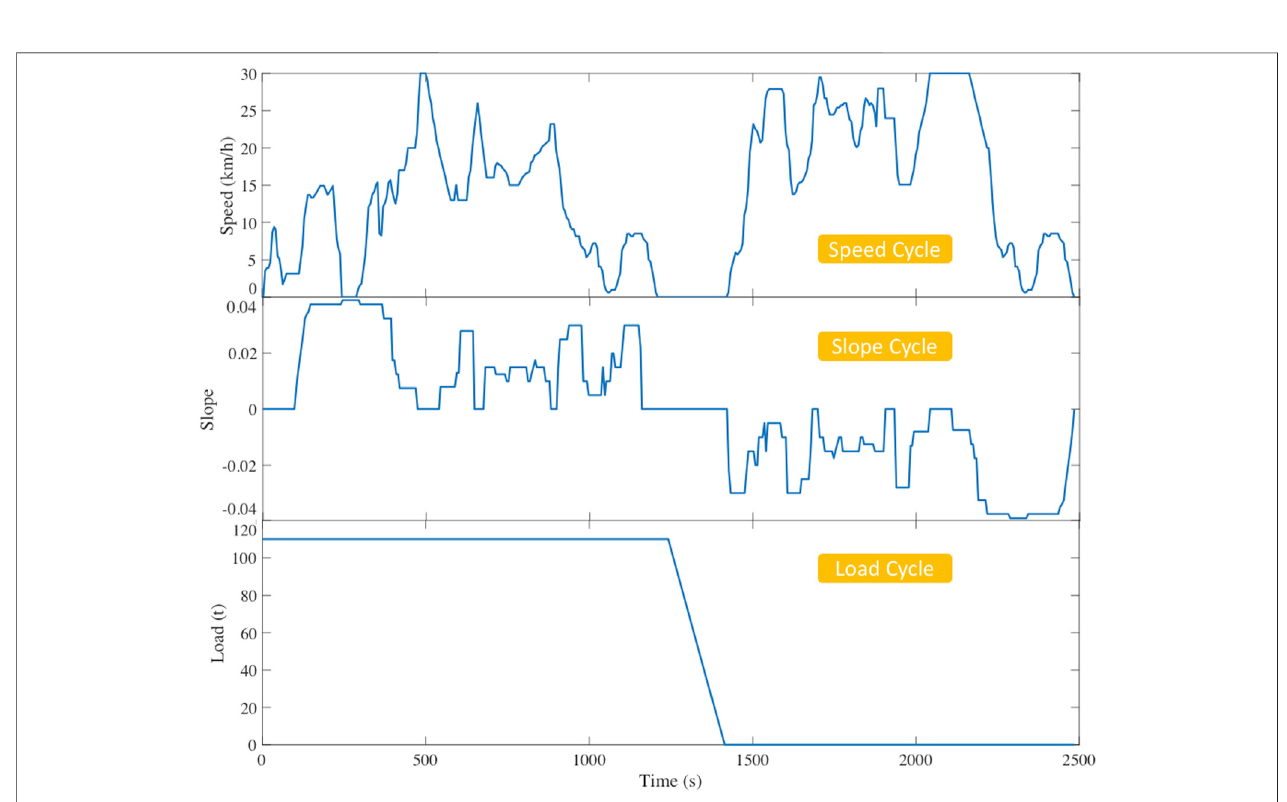
FIGURE 5 | Actual working cycle of the target